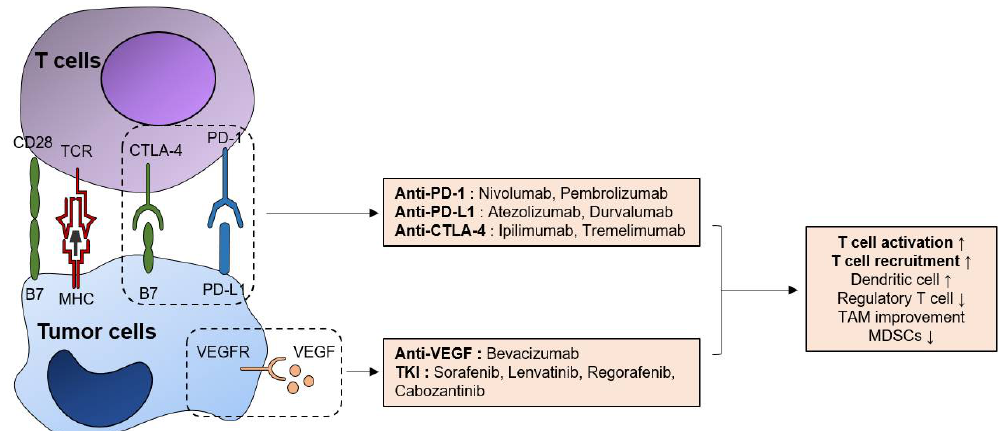
Figure 1. Immunologic effects of currently available systemic agents for HCC treatment. Currently available ICBs, such as anti-PD-1, anti-PD-L1, and anti-CTLA-4 can activate anti-tumor T-cell responses via the augmentation of TCR-mediated T-cell activation (signal 1) and CD28-B7 interaction (signal 2). Additionally, anti-VEGF bevacizumab also has T-cell functional enhancing effects, both directly and indirectly by regulating immunosuppressive cell populations such as tumor-associated macrophages (TAMs) and MDSCs. TKIs have various impacts on the anti-tumor immune responses, but they all have anti-VEGF effects and augment anti-tumor immune responses by inhibiting VEGF-VEGFR pathway.